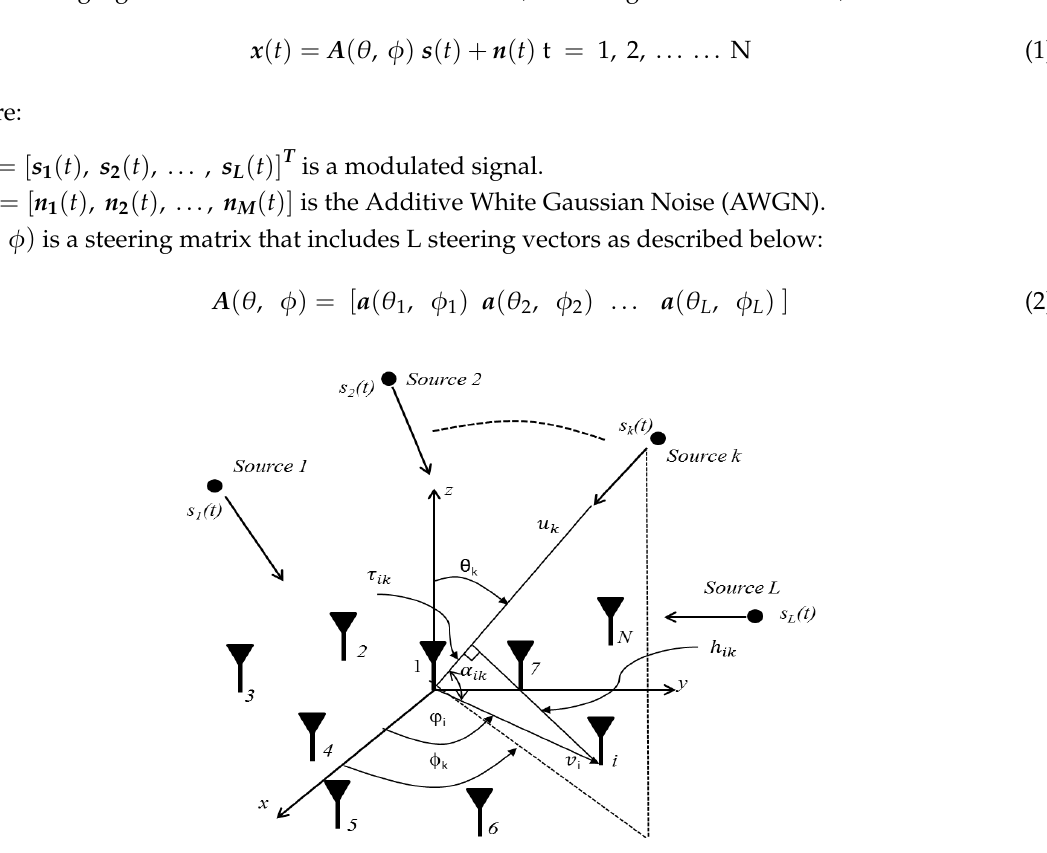
Figure 1. The Angle of Arrival problem formulation with M-Arbitrary antenna elements and L arrival signals